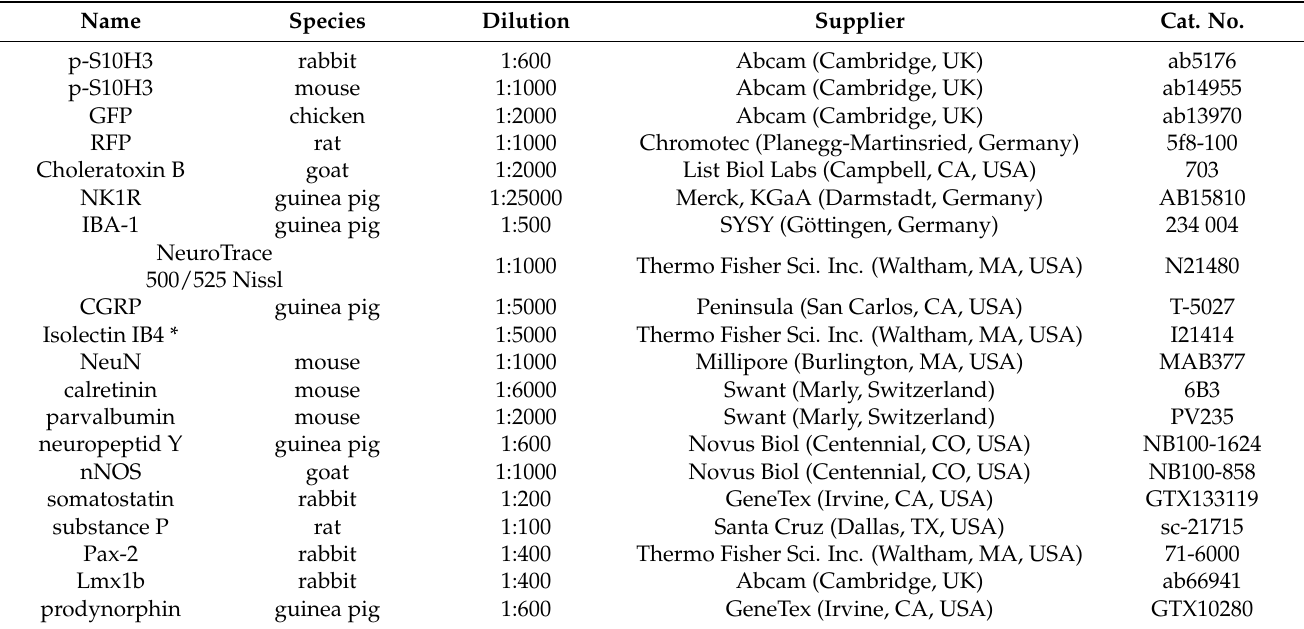
Table 4. Details of primary antibodies used for immunofluorescent